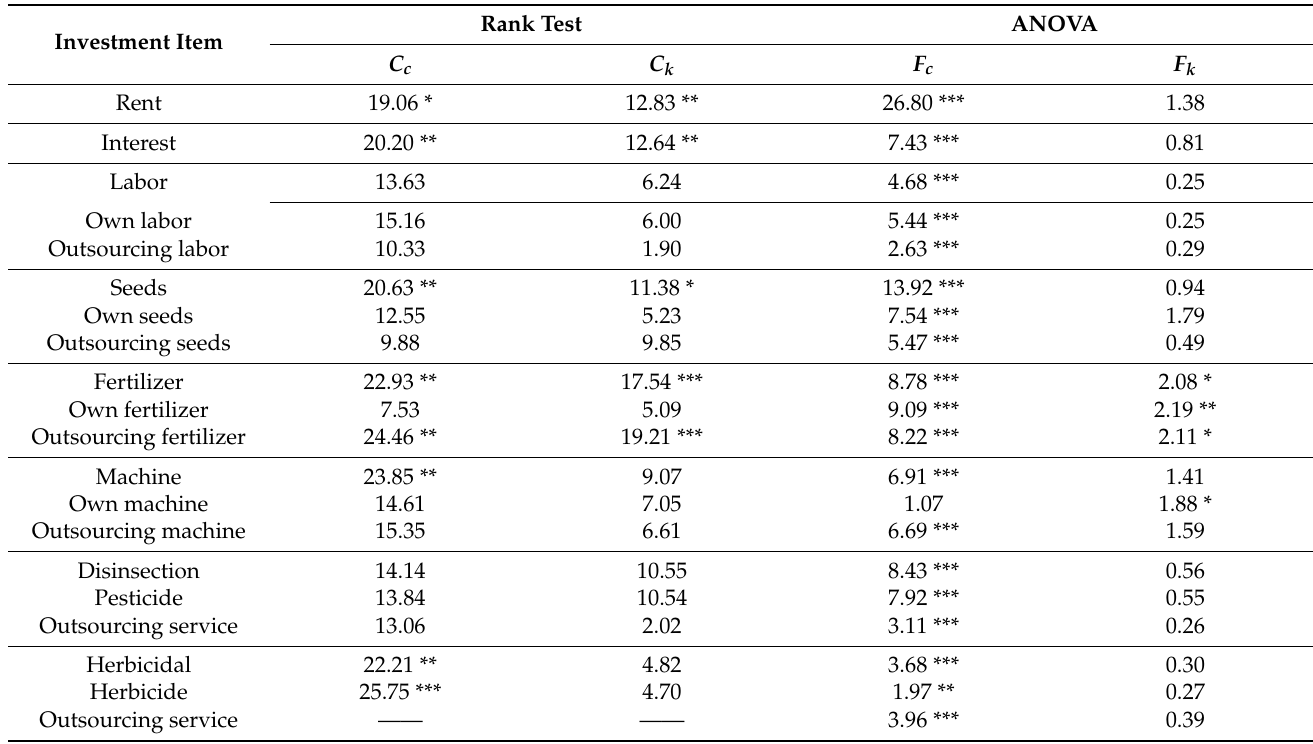
Table A2. Transaction Costs versus Knowledge Comparisons Using Two-factor Rank Test and